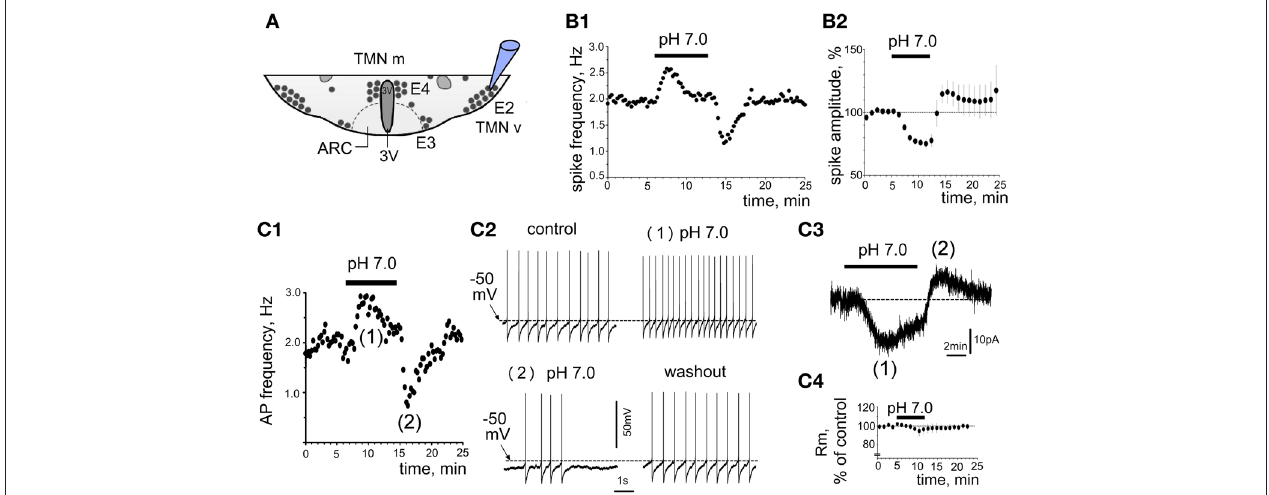
FIGURE 1 | Proton-induced increase in TMN neuron firing. (A) Schematic presentation of the coronal hypothalamic slice indicates the TMN groups (E2 corresponds to ventrolateral TMN, whereas medial TMN contains the E3, E4 groups). 3V, third ventricle; ARC, arcuate nucleus. Electrode points to the recording site E2. (B1,2) Firing of TMN neuron recorded in cell-attached mode in control at pH 7.4 and at pH 7.0. (B1) Time course of firing-frequency in representative neuron. Every point on the histogram represents the frequency averaged for 15s of recording. (B2) Change in the amplitude of action potential currents during acidification (each point: average recorded during 1min in 6 neurons). (C1) Current clamp recording from one TMN neuron illustrates the action potential (AP) frequency in response to low pH.